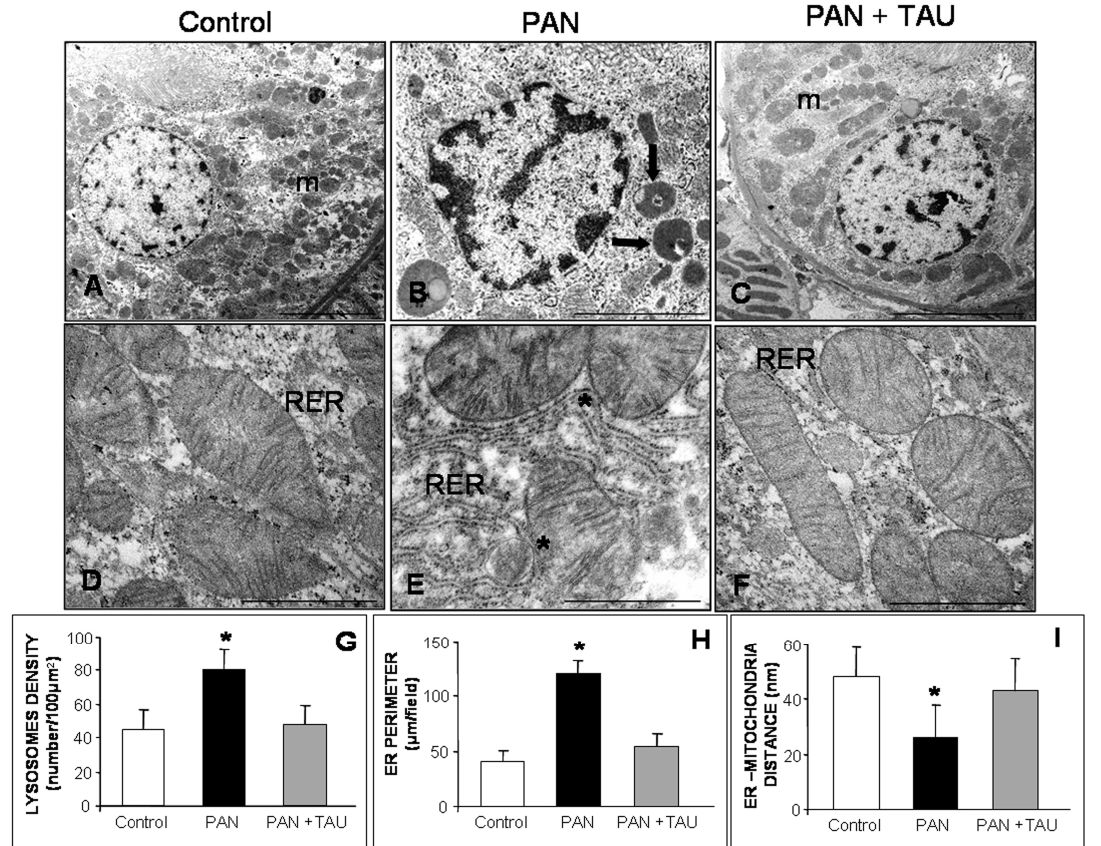
Figure 6. Ultrastructural evaluation at cortical proximal tubular level . ( A , D ) Lysosomes and mitochondria in cortical proximal tubules-S1 segment in control, ( B , E ) PAN nephrotic rats and ( C , F ) PAN rats pre-treated with TAU. ( m ): mitochondria; (RER): rough endoplasmic reticulum; arrow identifies lysosomes and asterisks identify the contact between organelles. ( A – C ) bars represent 1 µm and ( D – F ) bars represent 500 nm. Quantitative estimation of ( G ) lysosomal density, ( H ) RER perimeter, ( I ) lysosomes-mitochondria juxtaposition. * p < 0.05 versus control and PAN pre-treated with TAU groups.